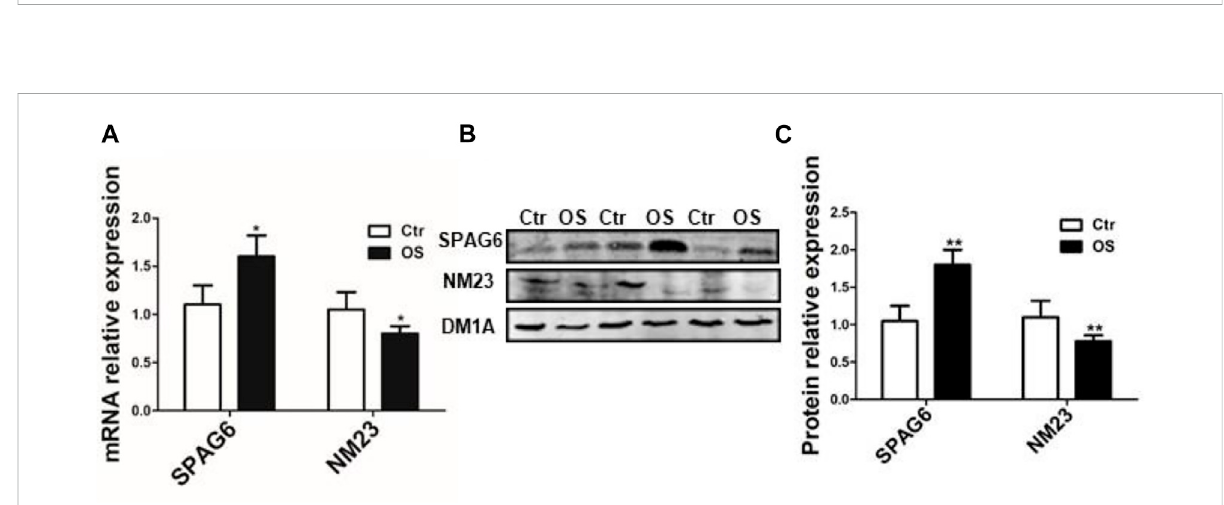
FIGURE 2 qRT-PCR and Western blot analysis of SPAG6 and NM23 in osteosarcoma and adjacent normal muscle tissues (control). (A) SPAG6 and NM23 mRNAs were detected by qRT-PCR. (B) SPAG6 and NM23 proteins were detected by Western blotting in osteosarcoma and adjacent normal tissues. (C) Quantitative analysis was conducted, and the results were normalized against the levels of α -tubulin (DM1A). The data were presented with ±s ( n = 6). OS: osteosarcoma; Ctr: control (adjacent normal muscle tissues). * p < 0.05 vs. control